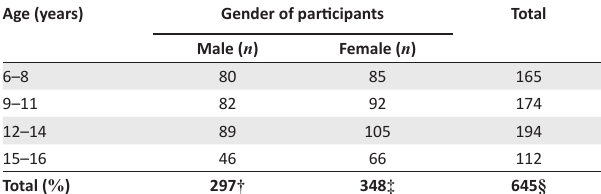
TABLE 1: Distribution of the participants’ gender in the different age groups.